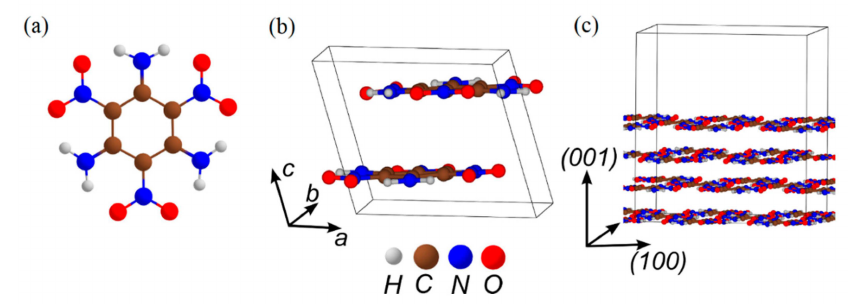
Figure 11. The structure of ( a ) a TATB molecule; ( b ) a TATB ideal crystal; and ( c ) a model supercell fragment of the (001) surface.